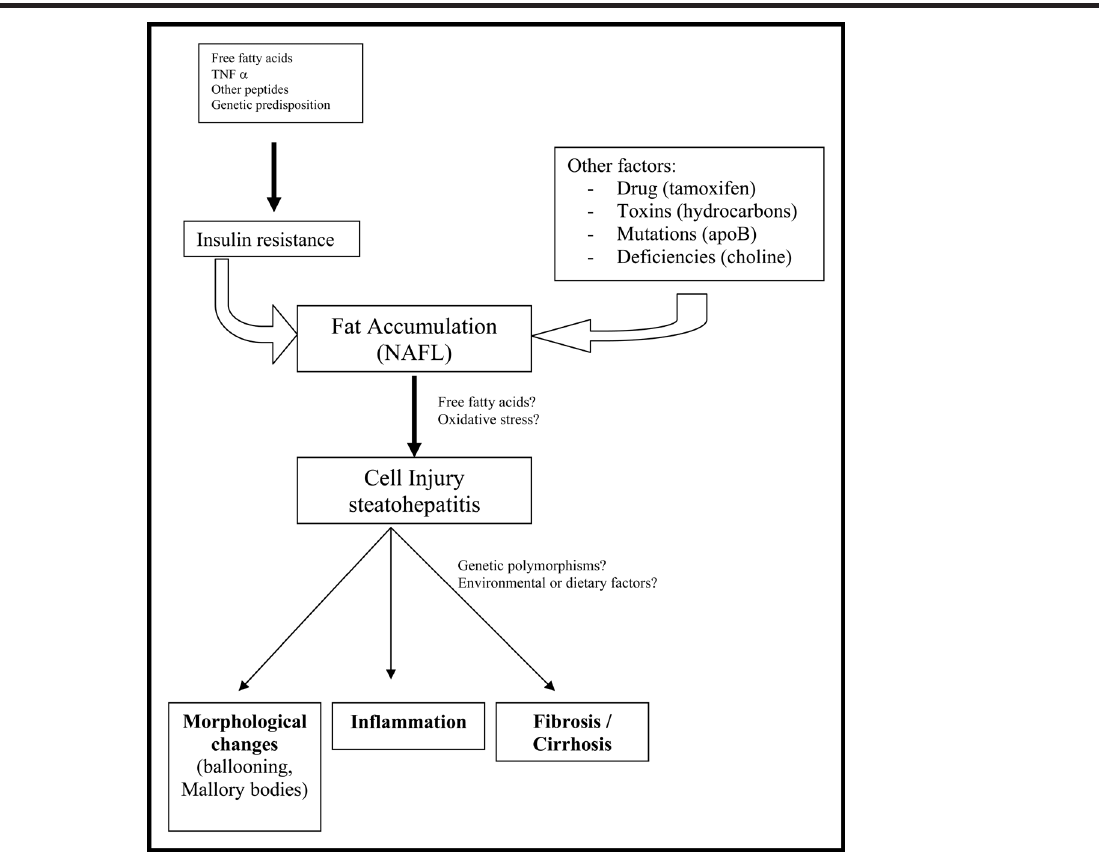
FIGURE 1 - Pathophysiology of the nonalcoholic fatty liver